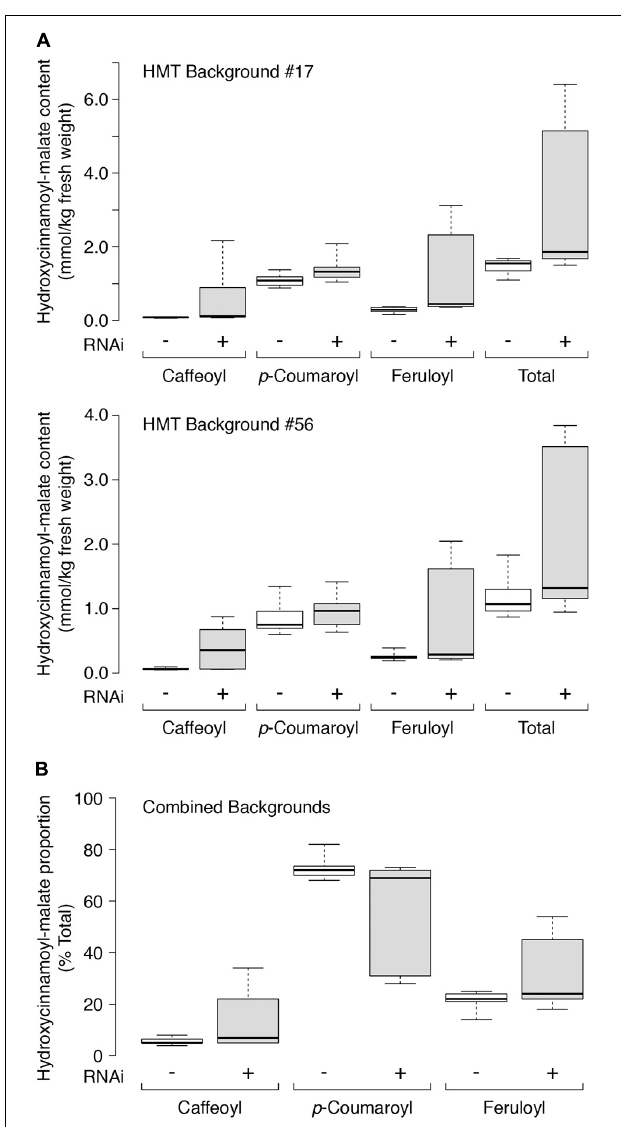
FIGURE 5 | (A) Hydroxycinnamoyl-malate content in leaves of HMT alfalfa plants retransformed with vector (negative control, –, white boxes) or CCOMT RNAi (+, gray boxes). Two different HMT alfalfa backgrounds (#17 and #56) were used as indicated with a minimum of five independent transformants in each group. (B) Proportion of individual hydroxycinnamoyl-malate esters as percent of total for leaves in both backgrounds with 24 and 21 independent transformants analyzed for the vector and RNAi groups, respectively. Labels are as in A above. For all panels, center lines show the medians, box limits indicate the 25th and 75th percentiles as determined by R software, whiskers extend to minimum and maximum